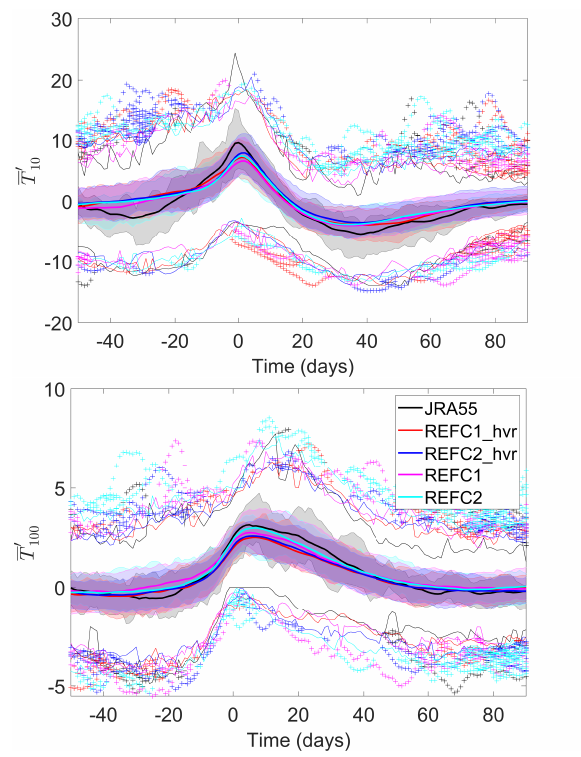
Figure 4. Composite of the temperature anomaly of the polar layer during the SSWs. Top panel 10 hPa; bottom panel 100 hPa. The abscissa shows the time in days from the central date of the event. The bold lines indicate the average values. The shaded area corresponds to the interquartile range, and the solid lines show the limit of typical values. Outliers and values ≥ 1.5 times the interquartile range are marked with